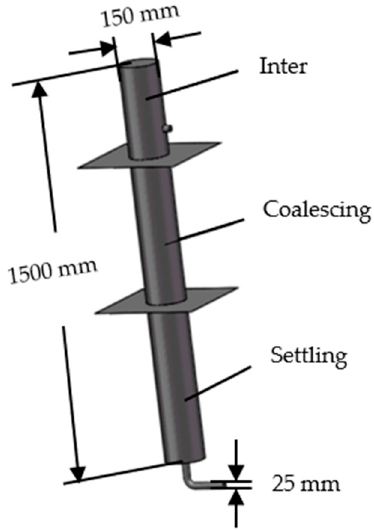
Figure 3. Geometric structure of discrete pipe.